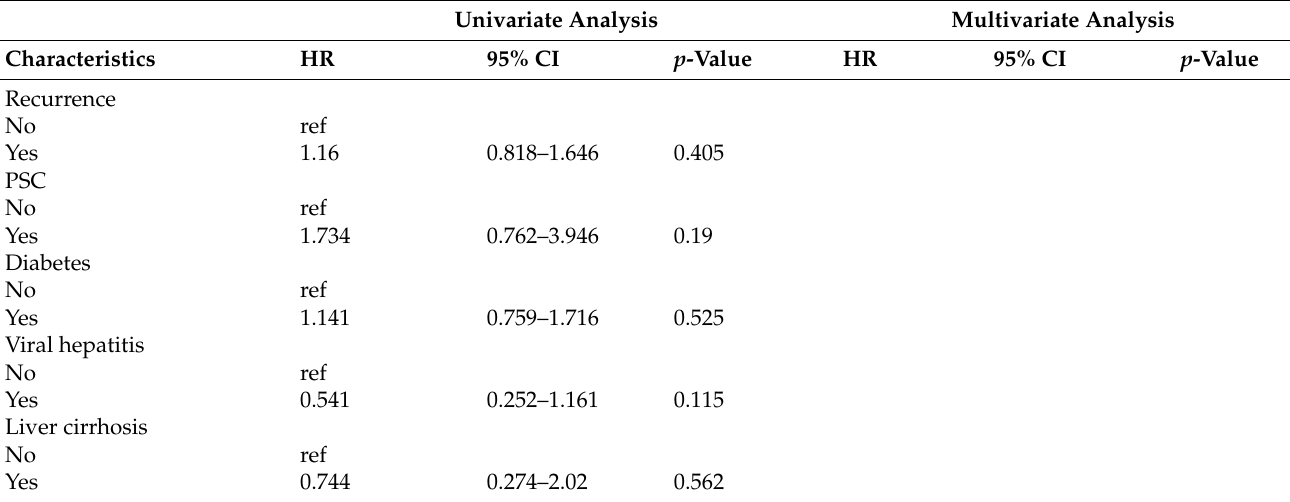
Table 2. Cont. Univariate Analysis Multivariate